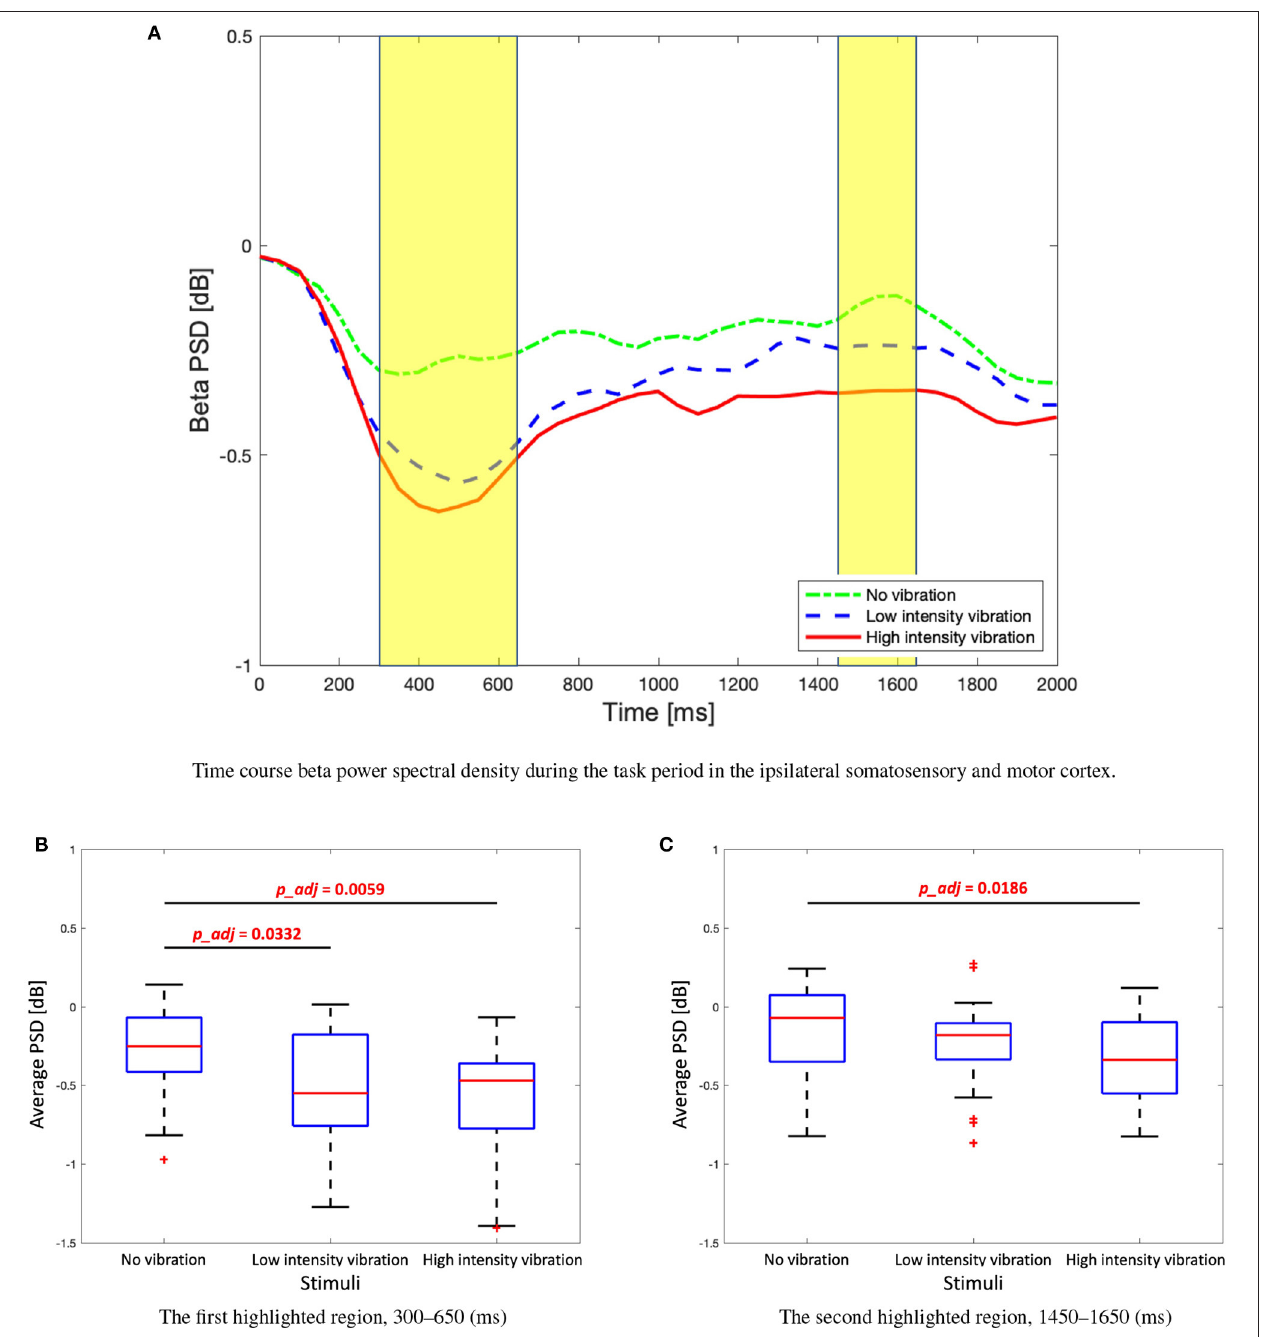
FIGURE 7 | (A) Time course beta power spectral density during the task period in the ipsilateral somatosensory and motor cortex (C3, Cp1, and Cp5). Two highlighted periods indicate significant differences among three stimuli. (B) Box plots to show average beta power spectral density of the first highlighted regions. One-way analysis of variance (ANOVA), F (2,86) = 6.5, Holm–Bonferroni correction. (C) Box plots to show average beta power spectral density of the second highlighted regions. One-way ANOVA, F (2,86) = 4.46, Holm–Bonferroni correction.